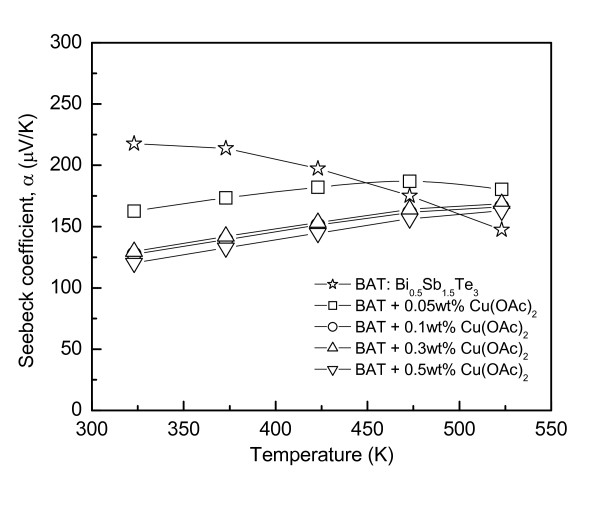
Seebeck coefficient of Cu-dispersed Bi0.5Sb1.5Te3.